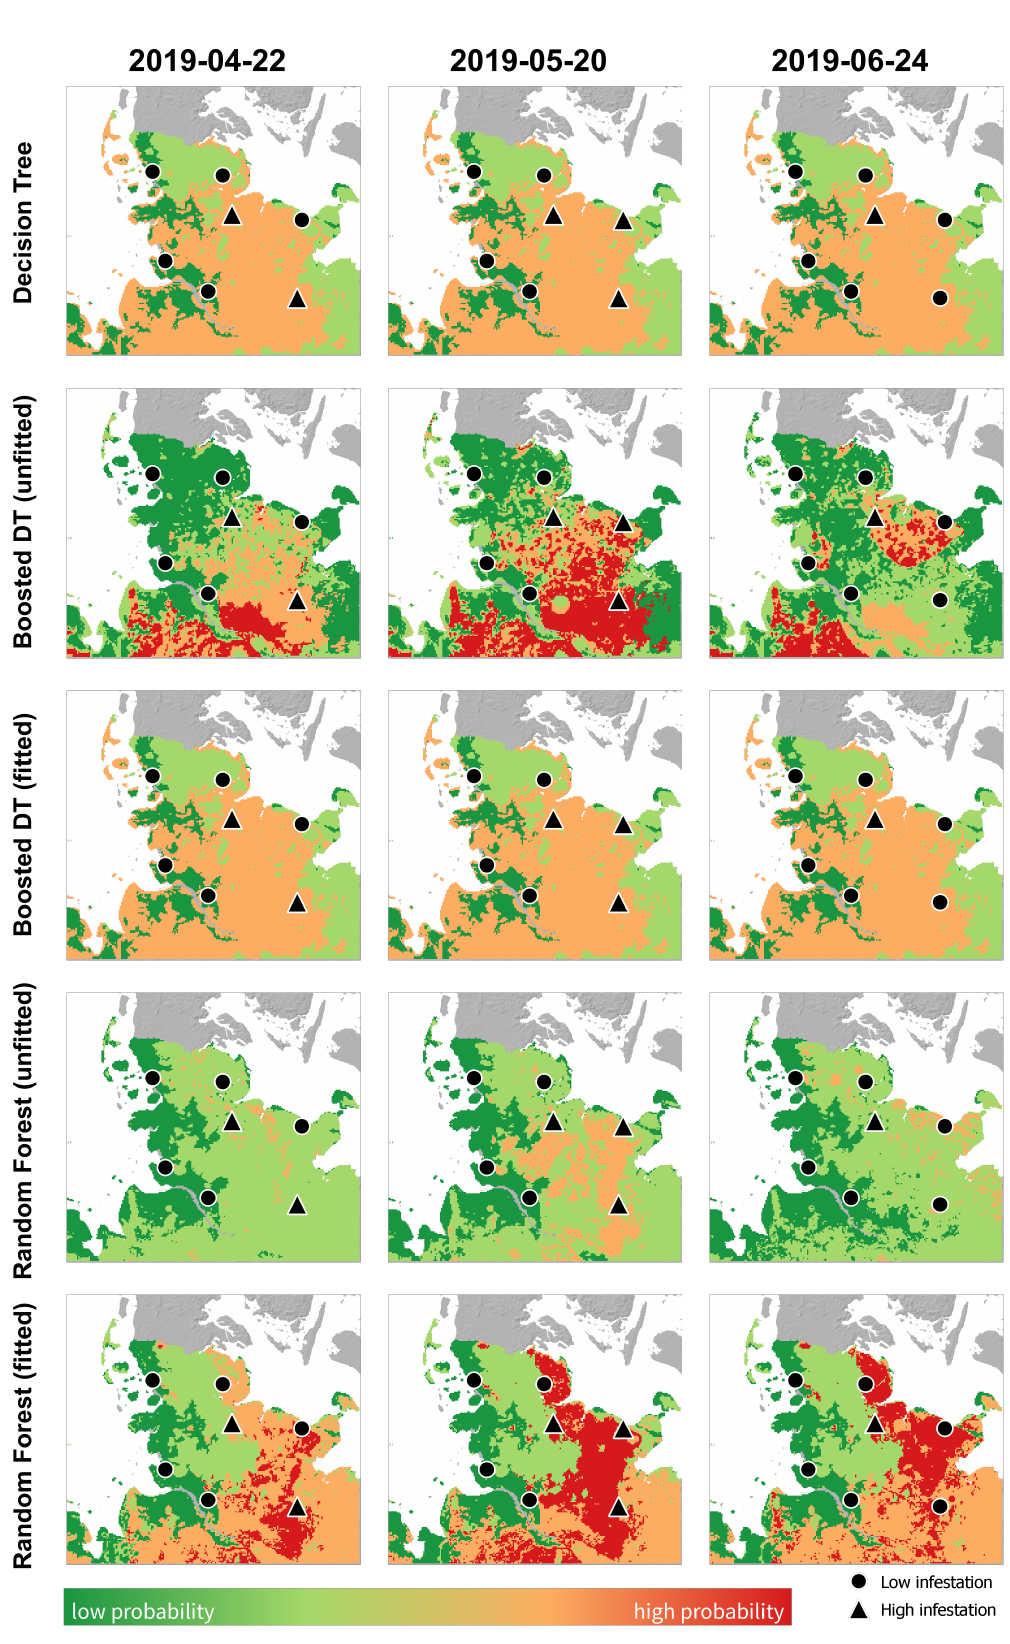
Figure 5. Predicted probabilities exceeding the powdery mildews’ threshold value (70%) on wheat in the study area, applying different machine learning procedures at selected dates in 2019. Observations of the IPM monitoring are included as spots and